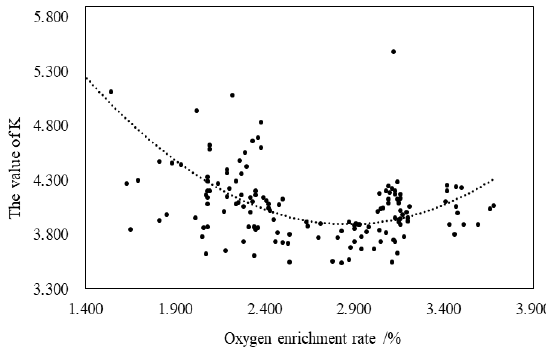
Figure 6. Effect of K for different oxygen enrichment